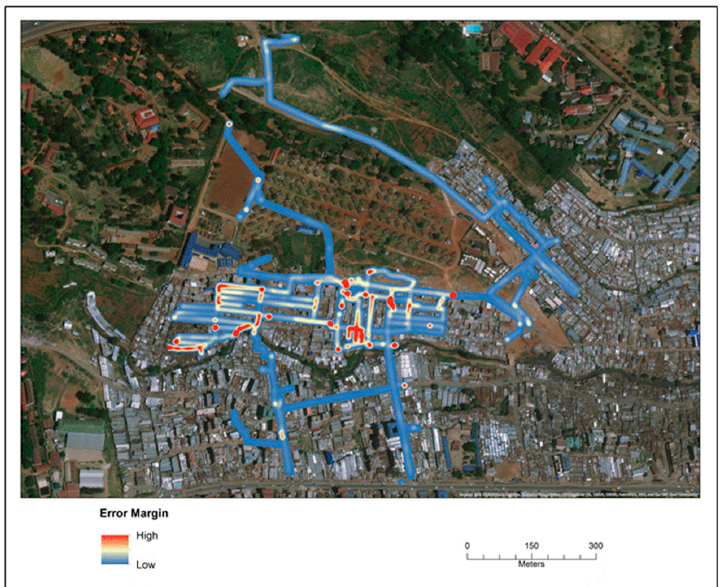
Figure 6. A hot spot map showing intensities of error, meaning the distance between the actual and corrected location for all coordinates along each SV path.